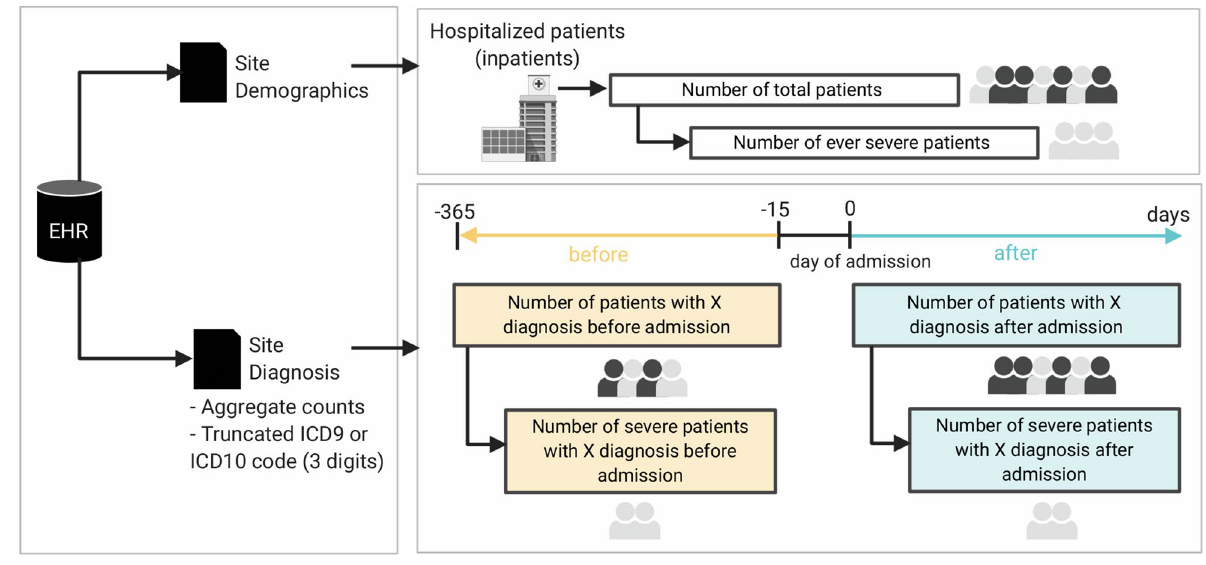
Figure 1. Schematic diagram of the cohort and data generation workflow for each healthcare system. The figure was created with Biorender